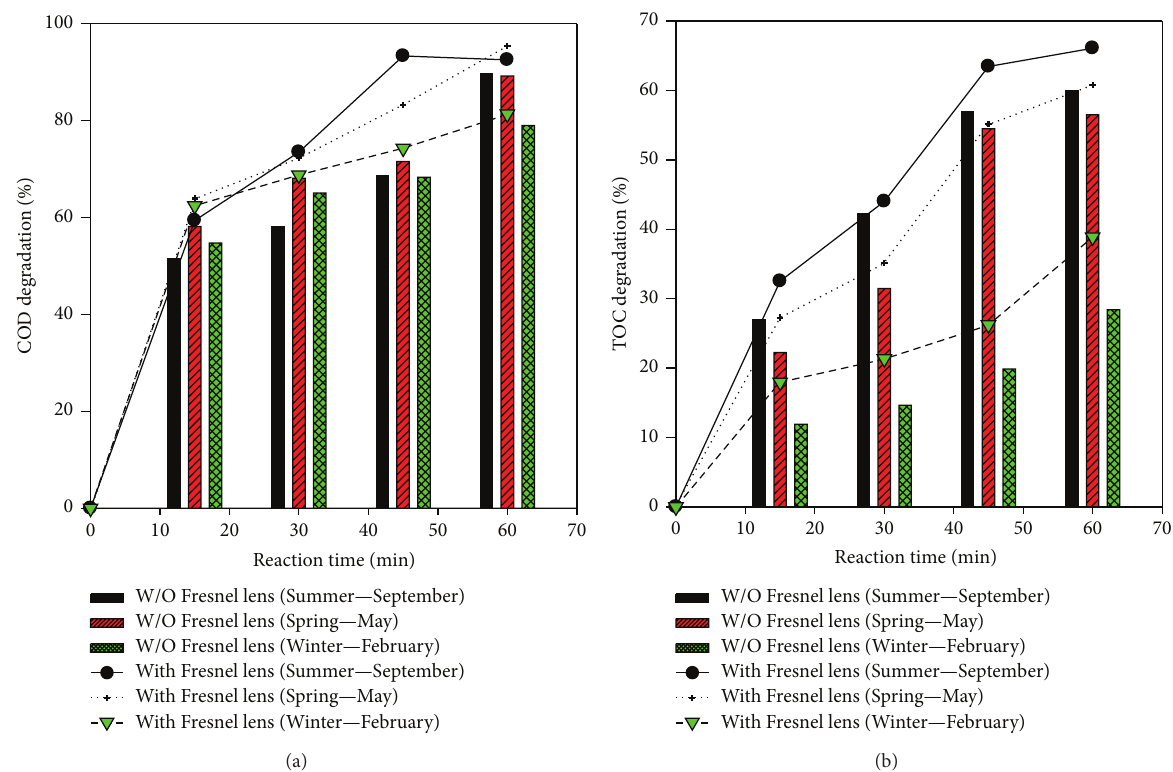
Figure 3: Effect of Fresnel lens on the degradation efficiency of (a) COD and (b) TOC of electro-optical industry wastewater treated by solar IPCC reactor in different seasons (initial pH: 3.0; [H 2 O 2 ] 0 /COD 0 = 2.0 g/g; [H 2 O 2 ] 0 /[Fe 2+ ] 0 = 7.5).